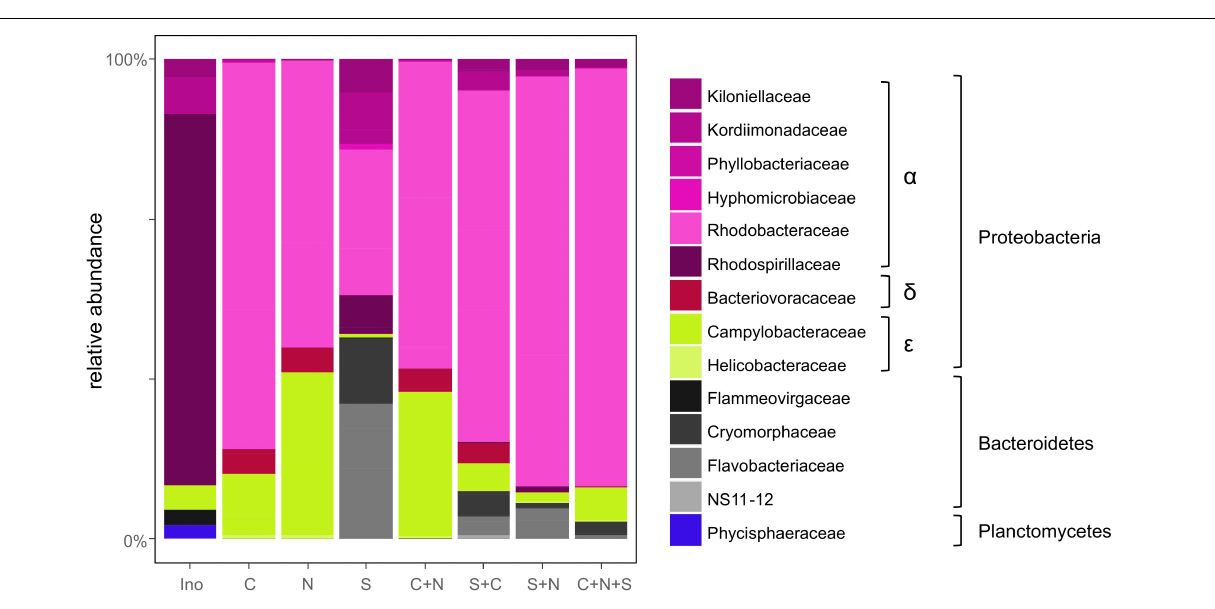
FIGURE 3 | Bacterial community composition follows the diatom community. Relative bacterial abundances present in the original inoculum (Ino) or when grown with either C. closterium [C], N. phyllepta [N], S. robusta [S], or a combination of these diatoms. The different bacterial orders are depicted using different